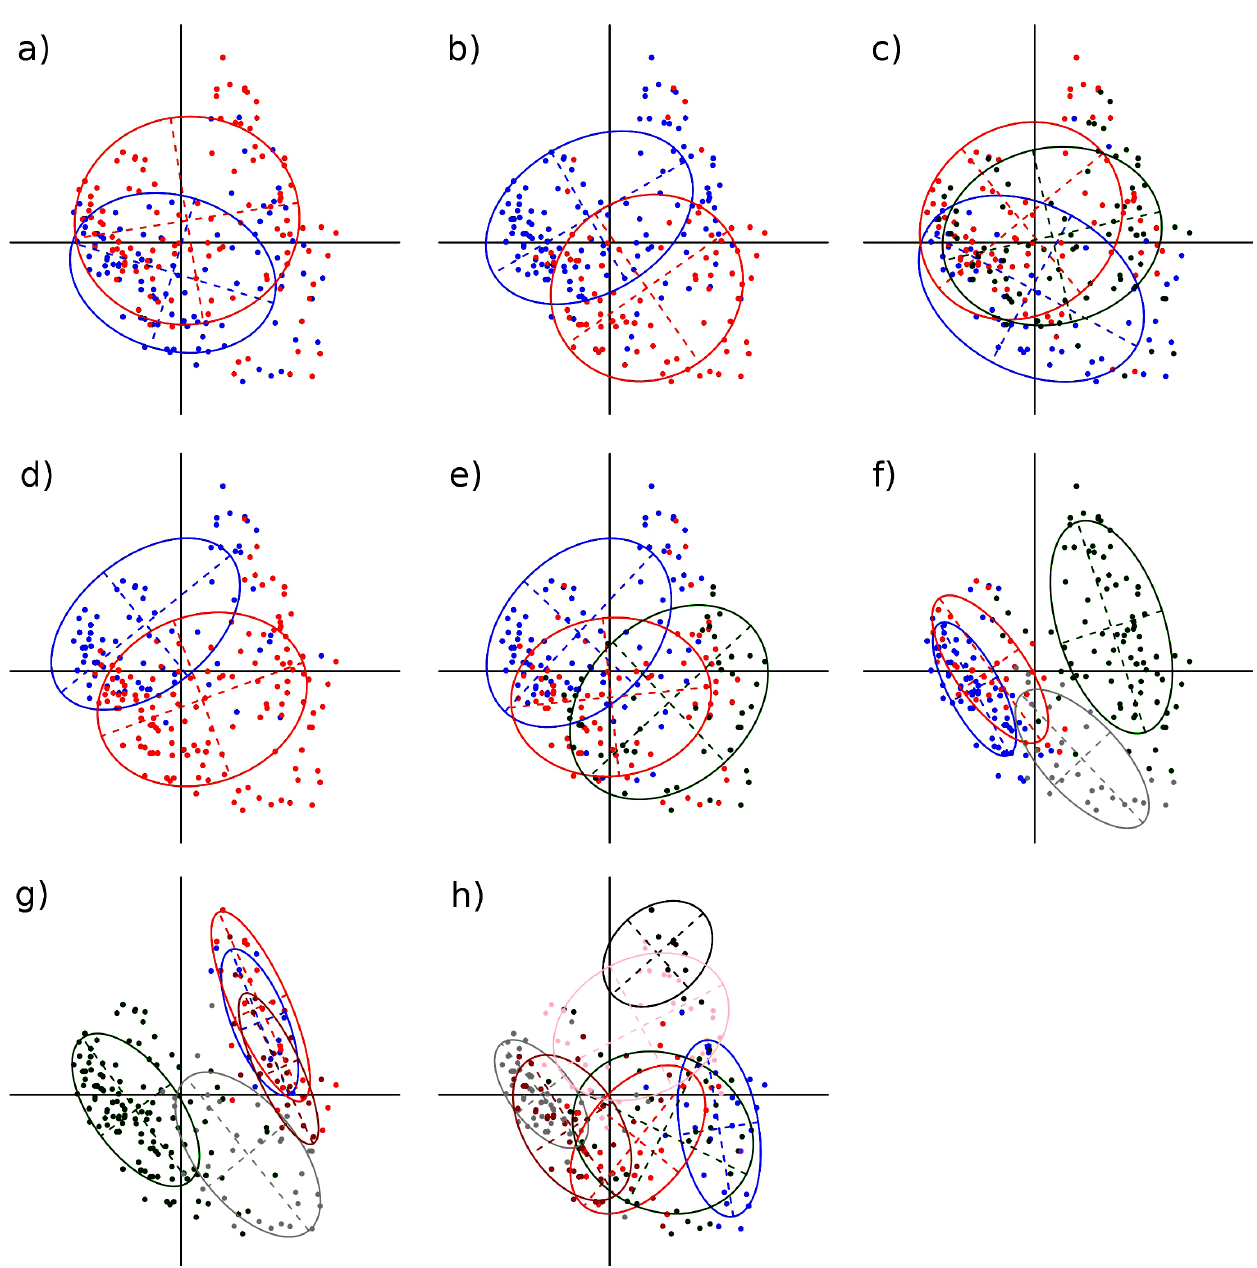
Fig. 4 . Multiple correspondence analysis on the 305 circulation events. a) Cropping season: good year (2010) in blue and bad year (2011) in red. b) Gender of the recipient: female in blue, male in red. c) Economic status of the household: poor households in blue, intermediate households in red, and rich households in green. d) Categories of acquired crops: major crops in red and secondary crops in blue. e) Quantities acquired: less than one cup in blue, between one and two cups in red, and more than two cups in green. f) Origin of seed sources: within the same household in red, within the same district in blue, within the same village in grey, and from outside the same village in green. g) Geographical distance between provider and recipient: less than one kilometer in green, from one to three kilometers in grey, from three to five kilometers in dark red, from five to 10 kilometers in blue, and more than 10 kilometers in red. h) Social relationships between transacting partners: agnates in light red, uterines in light grey, in-laws in dark grey, friends in green, neighbors in dark red, acquaintances in blue, strangers in black, and others in purple. Ellipses contain 63% of the points per